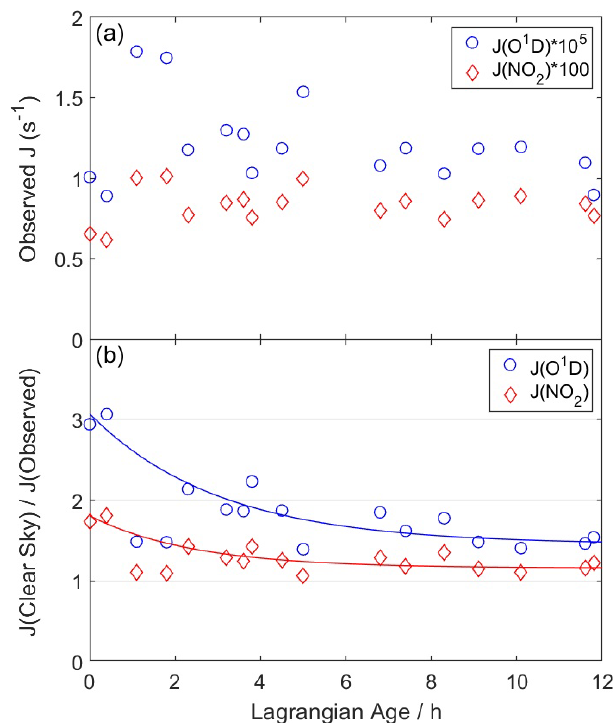
Figure A1. (a) Average observed photolysis frequencies for each WAS sample for O 3 → O( 1 D ) + O 2 (blue circles) and NO 2 → NO + O( 3 P) (red diamonds). (b) Ratio of clear-sky to ob- served photolysis frequencies. Clear-sky values are calculated using tropospheric ultraviolet and visible radiative transfer model (TUV) solar spectra and F0AM parameterizations. Lines represent least squares fits to Eq. (A2). The two points between ages of 1–2h are excluded from the